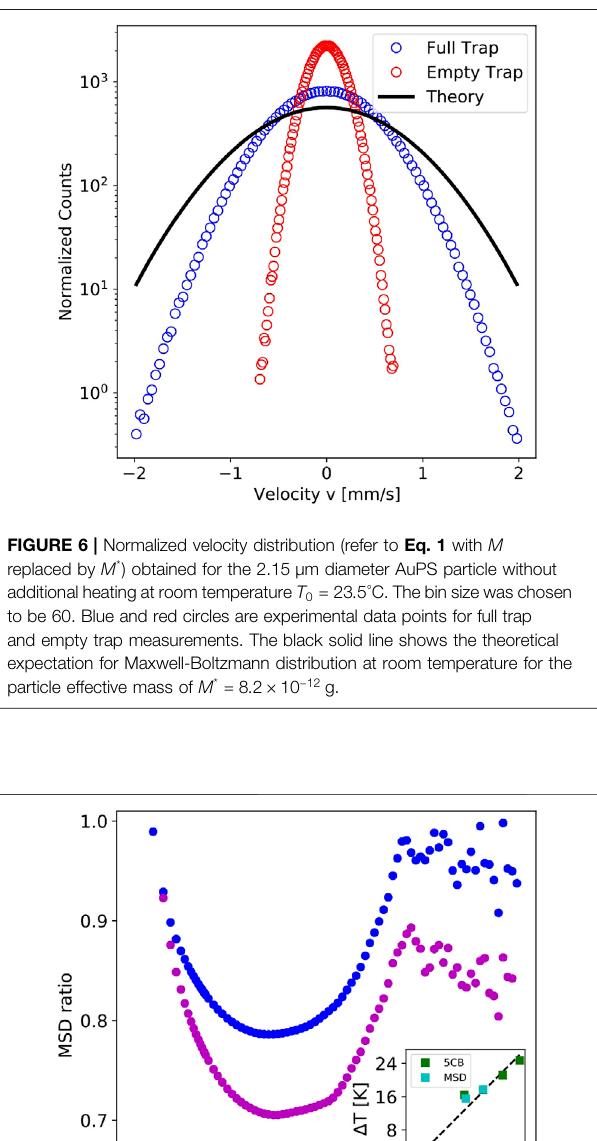
Frontiers in Physics |